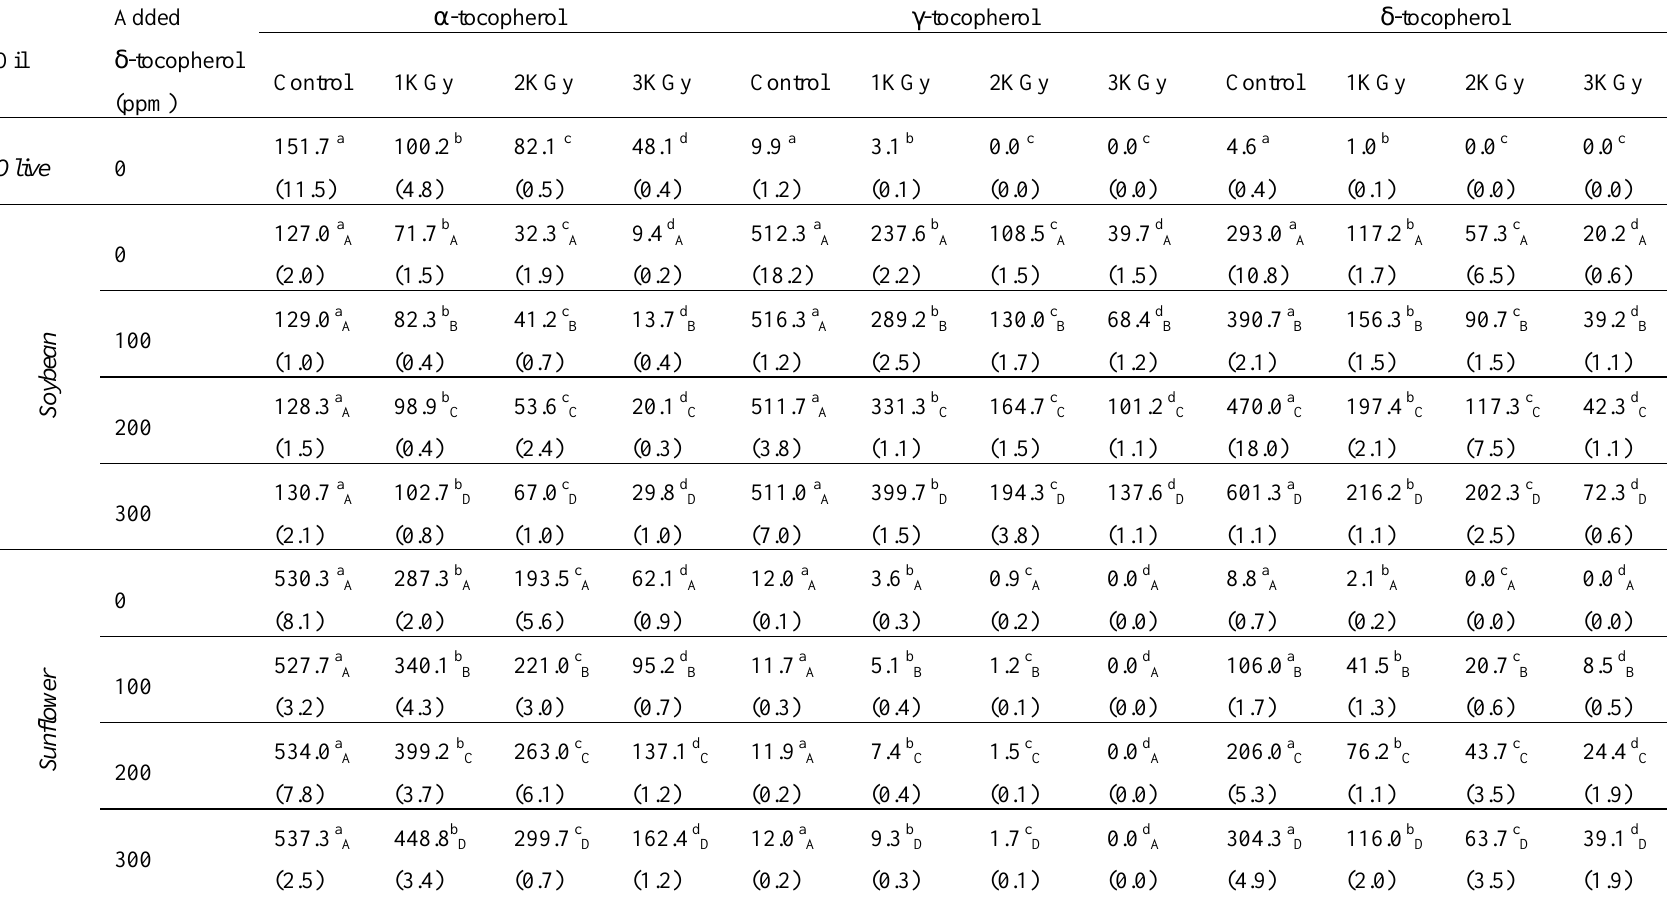
Table 2. Tocopherol content (ppm) of vegetable oils before and after